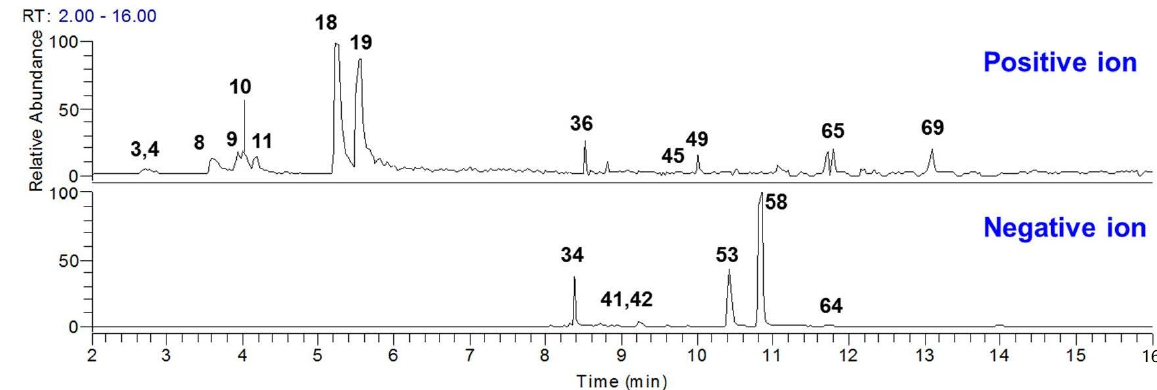
Figure 3. The t-SIM chromatograms of rat plasms after oral administration of GDL Pill.